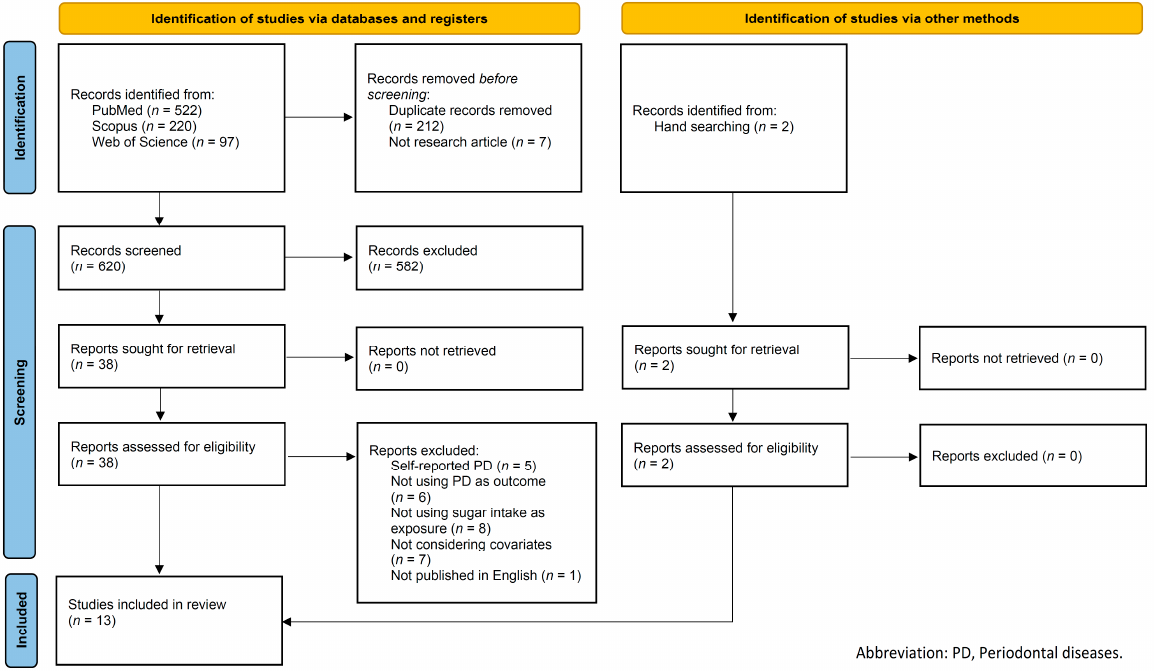
Figure 2. Flow diagram of literature selection.